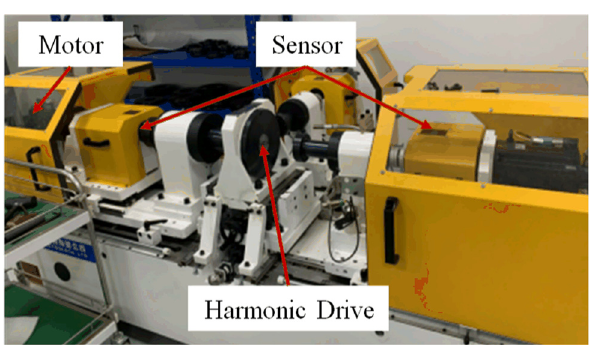
Figure 13: The comprehensive performance test platform of HD.